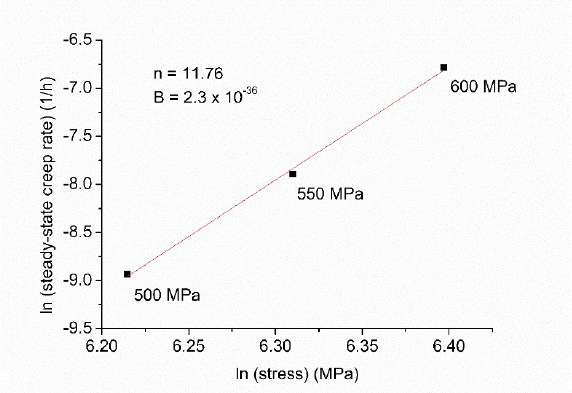
Figure 13. Steady-state creep rate dependence with the stress applied at 650 °C of the Inconel 625 alloy.